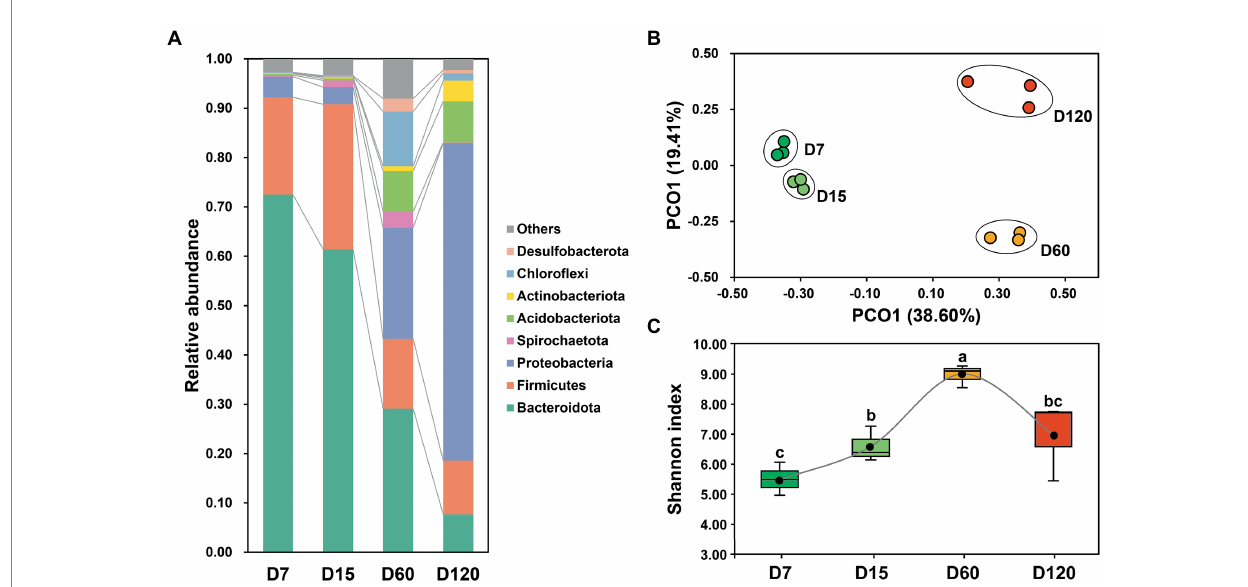
FIGURE 1 Variation of bacterial community composition during experimental session (A) . A PCoA plot of the bacterial community in different stage (B) . Dynamic variation of bacterial diversity during experimental session (C) . Different letters indicate significant differences as checked by the Kruskal-Wallis rank sum test ( p <